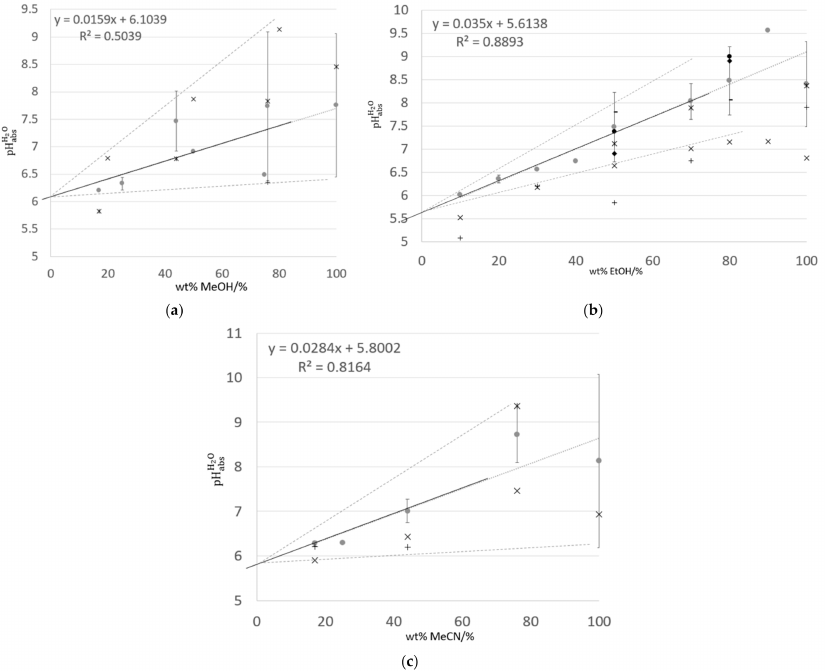
Figure 5. pH H 2 O values measured in different water—organic mixtures: ( a ) water–methanol, ( b ) water–ethanol and abs ( c ) water–acetonitrile. For the SCGE ( ‚ ), values are averaged between institutes. Error bars are calculated using Equation (1), and represent the distribution of values measured at different institutes. Solid line is the linear trend line for averaged pH H 2 O values measured using SCGE as a function of wt% organic content. Dotted lines are included as a guide to the abs expected variability in pH H 2 O values, which may be measured using SCGE for different water–organic ratios. ( a ) water– abs methanol mixtures: potential difference measured using combination (B, ˆ and F, *), half-cell (G, +), and SCGE (A, ‚ ). ( b ) water–ethanol mixtures: potential difference measured using combination (F, ˆ ), half-cell (G, *; H, + and ´ ; I, ˝ ; J, ♦ ), and SCGE (A, ‚ ). Values for electrodes H, I, and J are taken from [20]. ( c ) water–acetonitrile mixtures: potential difference measured using combination (F, ˆ ), half-cell (G, * and H, +), and SCGE (A, ‚